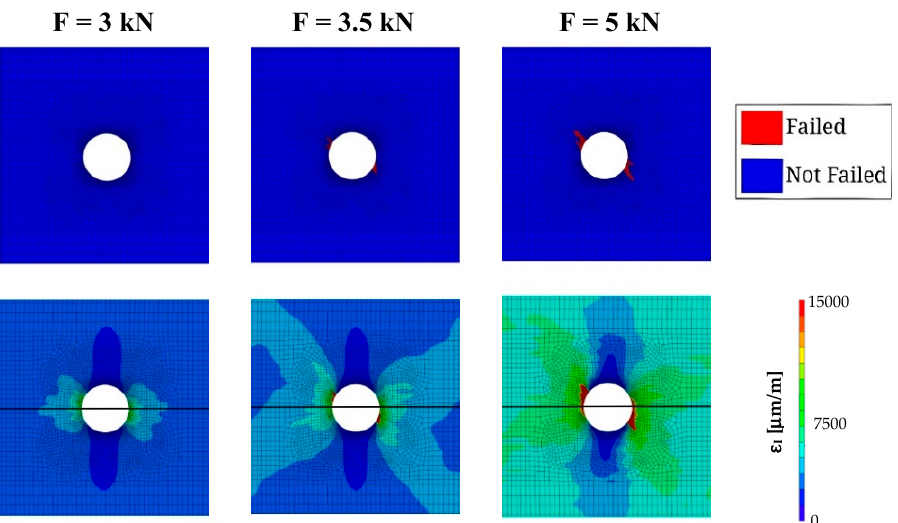
Figure 5. Matrix damage (IFF) and first principal strain ( ε I ) pattern